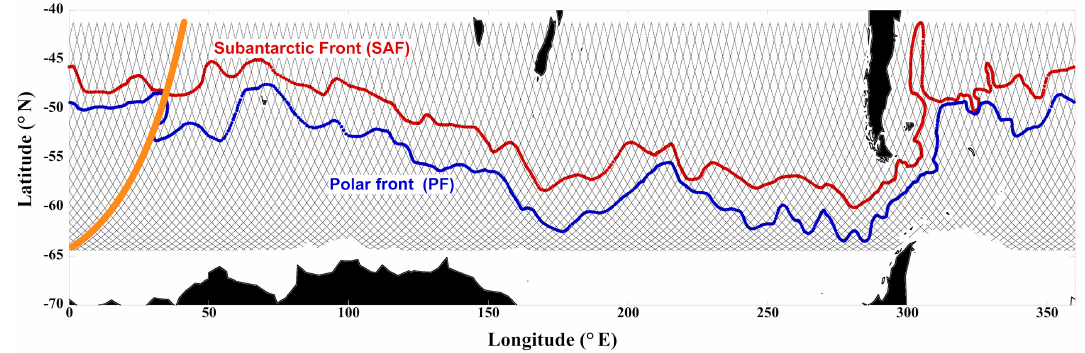
Figure 2. Positions of the T/P, Jason-1, Jason-2, and Jason-3 ground tracks used for this study (black lines) and the approximate locations of the Subantarctic Front (red line) and the polar front (blue line) as estimated by Orsi et al. (1995). The orange track shows the location of the pass used in analysis shown in Figs. 3 and